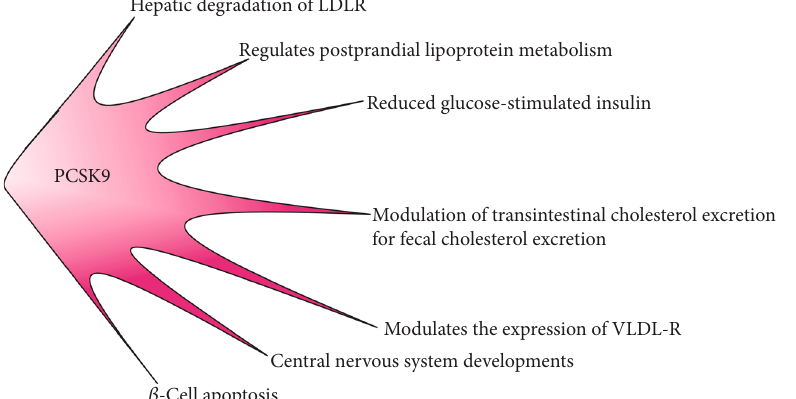
Figure 5: The biological functions of PCSK9. LDLR: low-density lipoprotein receptor; VLDLRs: very low-density lipoprotein